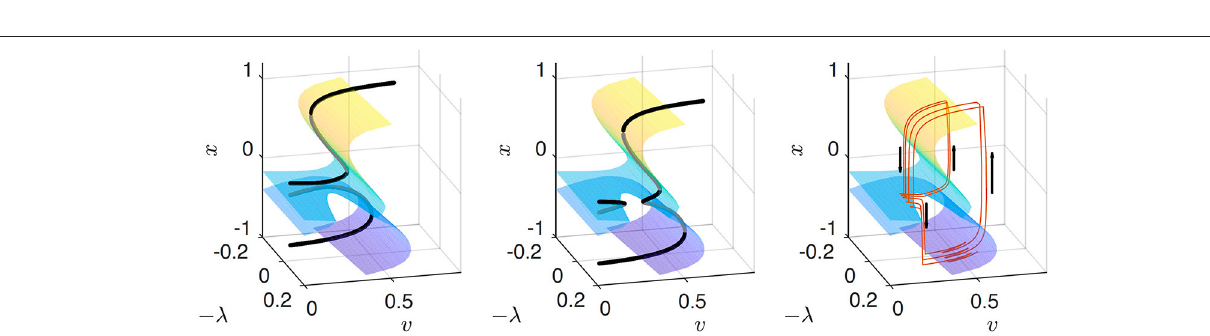
Frontiers in Physics |